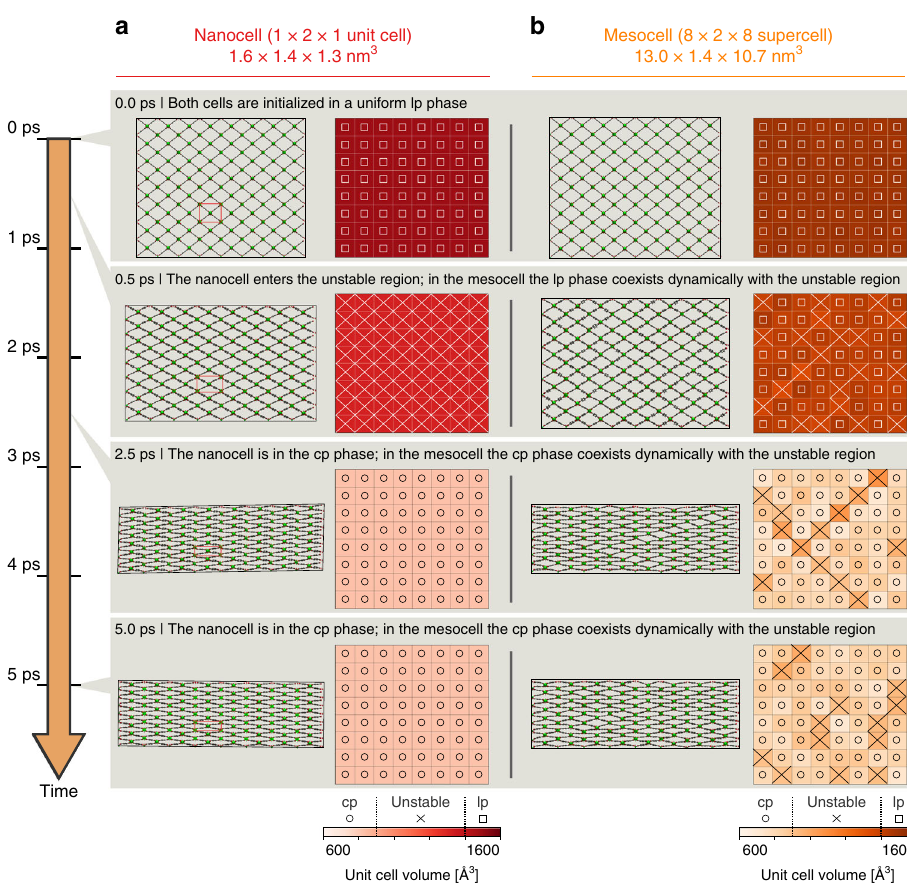
Fig. 2 Size-dependent mechanism underpinning the phase transition in MIL-53(Al). Visualization of the lp-to-cp transition in MIL-53(Al) during a constant- temperature constant-pressure simulation at 300 K and 40 MPa, using a a nanocell (1 × 2 × 1 unit cell), which is indicated with a red rectangle and periodically repeated to match the size of the mesocell, and b a mesocell (8 × 2 × 8 unit cell). The atomic visualizations are supplemented by schematic representations that are color coded based on the volume of the different subcells (structural classi fi cation). Furthermore, the mechanically stable closed- pore (cp) and large-pore (lp) phases and the intermediate unstable region are indicated by circles, squares, and crosses, respectively (mechanical classi fi cation). Due to periodic boundary conditions, spatial disorder is only tolerated within the simulation